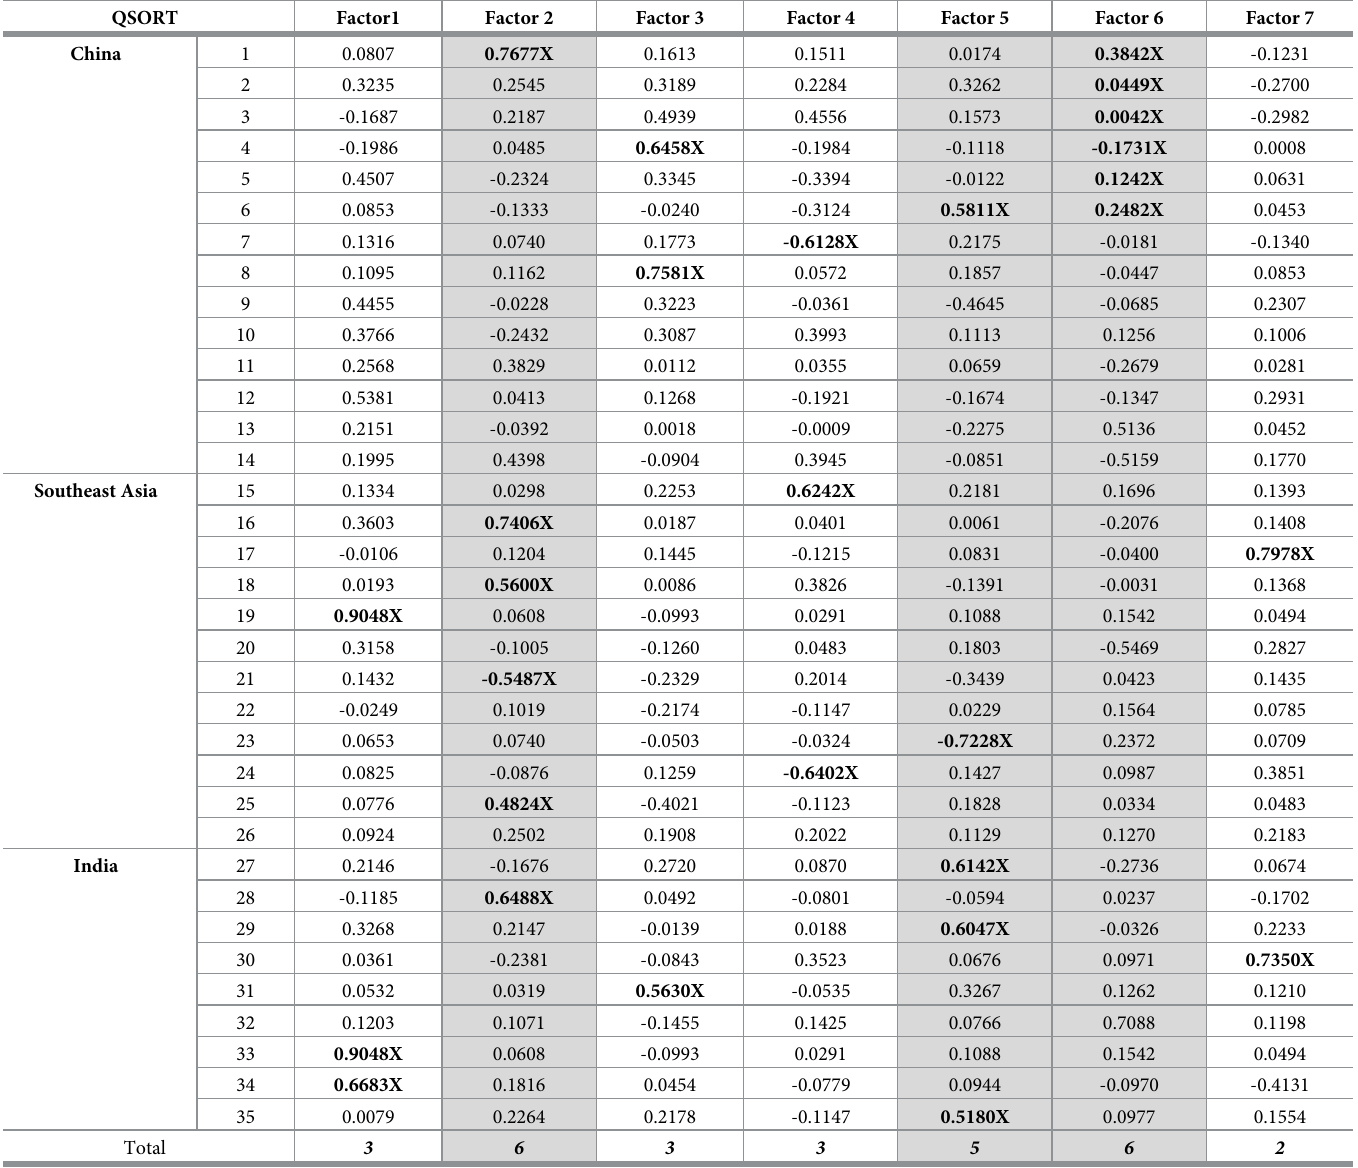
Table 1. Notable factors and geographical association (X denotes significant factor